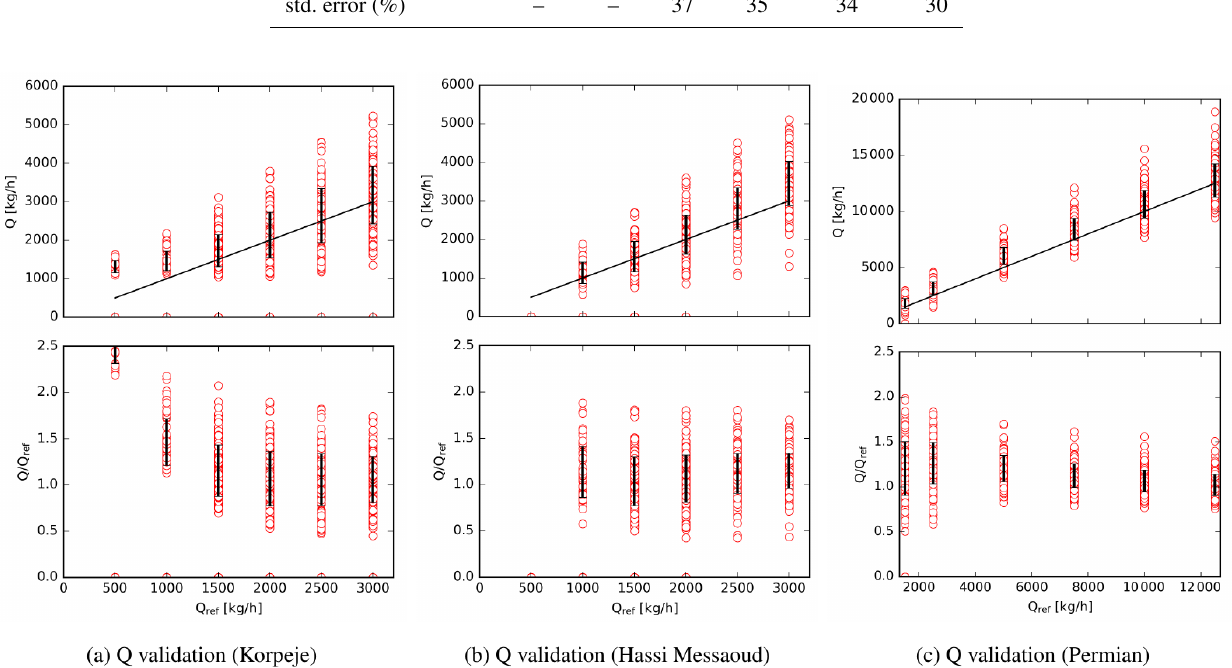
Figure 12. Q validation against reference values for acquisitions near the winter solstice. Similarly to Fig. 11, the validation is set for 221 plume shapes with a supervised detection masking criteria as detailed in Sect. 4. The graph also includes the mean and standard deviation of the errors at the selected flux rate